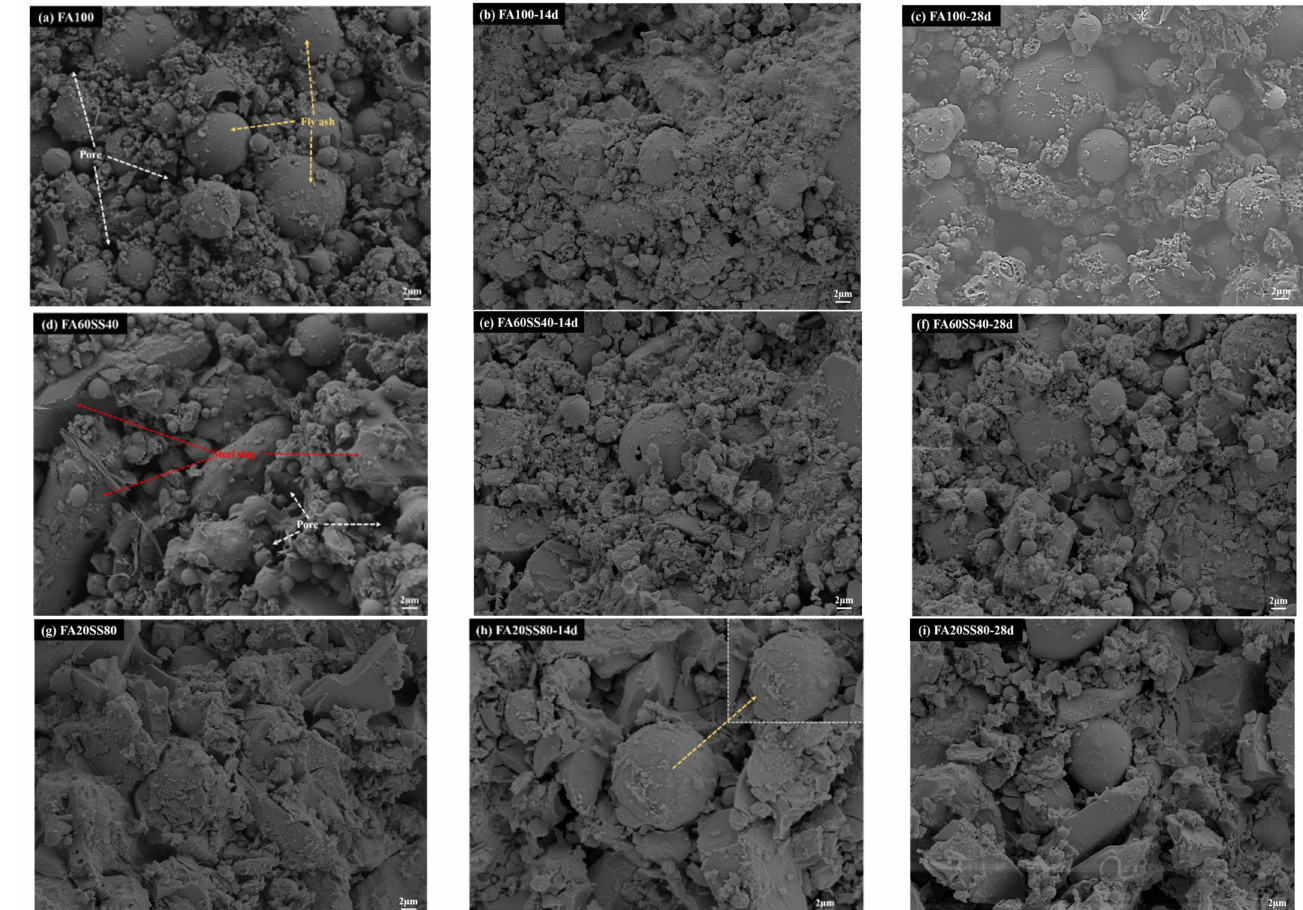
Figure 10. Morphology of geopolymers at the age of 3-day and after water